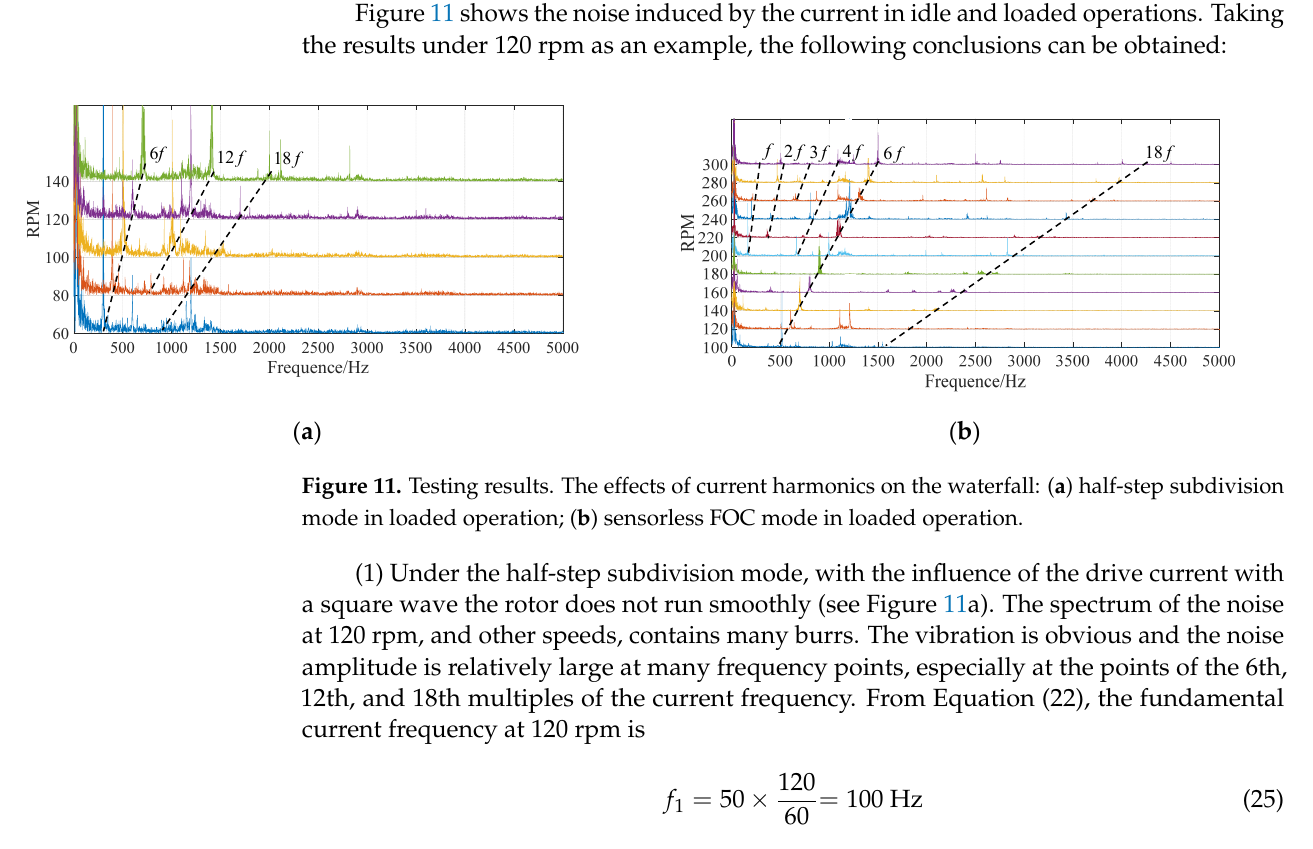
Figure 12. Testing result: the effects of chopping frequency on the waterfall.